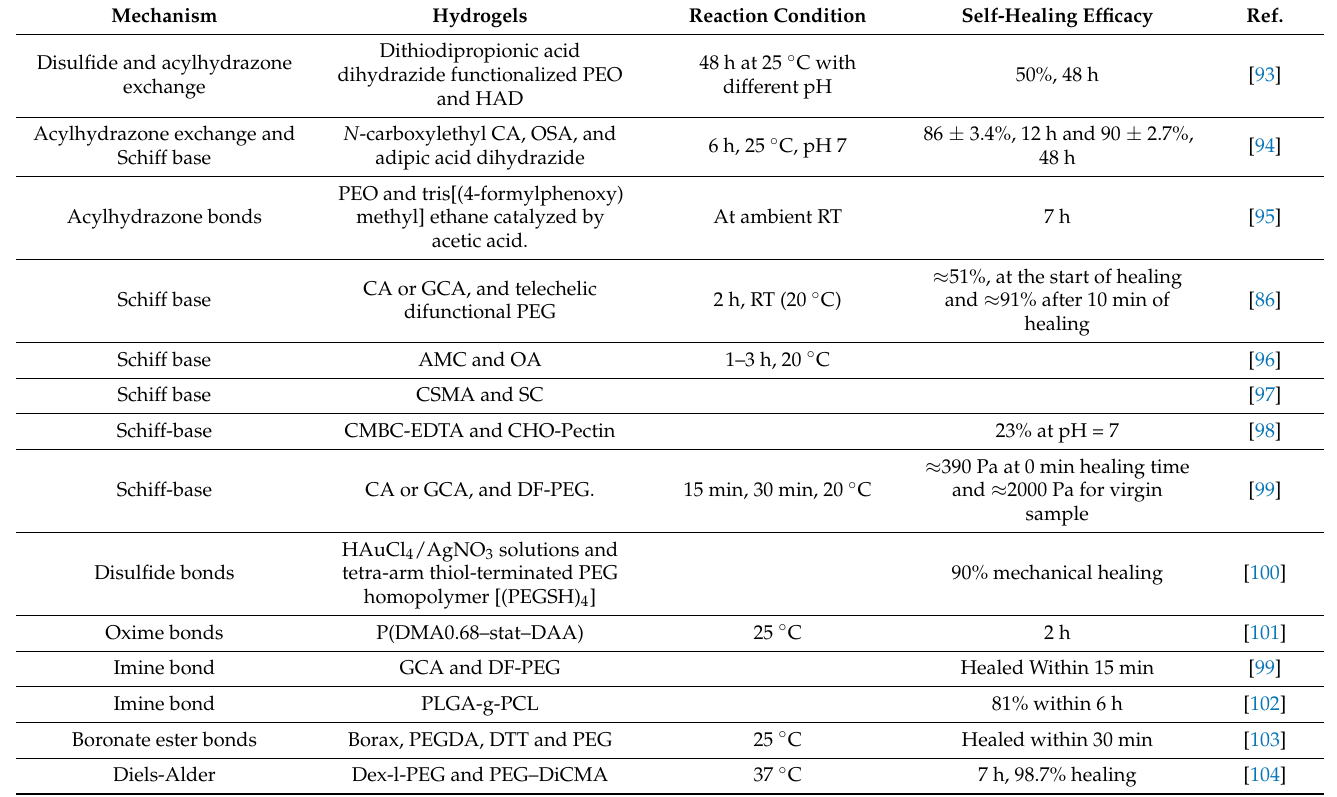
Table 2. Comparison of self-healing efficiency of hydrogels prepared for 3D/4D